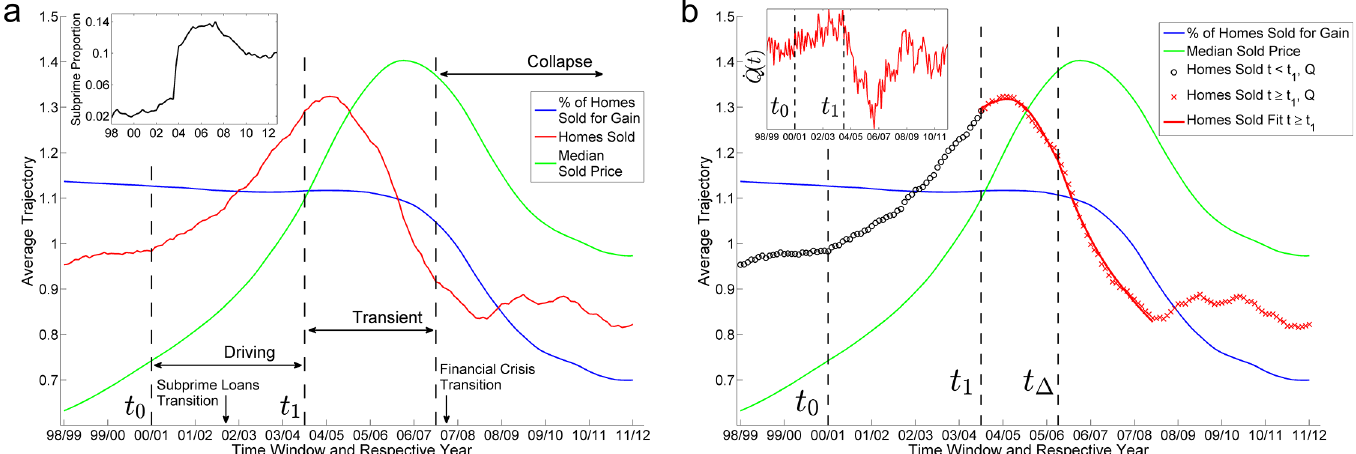
Fig 1. (a) The average normalized trajectories of the three variables are plotted against time . Dashed lines demarcate distinct periods of the trajectory of the US housing market. The start t 0 and end t 1 of the driving phase are marked by kinks in the homes sold trajectory and its gradient respectively while the start of the collapse phase is marked by a collapse in the median sale price and % of homes sold for gain trajectories. (inset) The line plot shows the subprime proportion of mortgages issued in the United States. The sudden jump in the fourth quarter of 2003 is marked on the main figure as the Subprime Loans Transition (October 2003). (b) The average normalized trajectory of the percentage of homes sold for gain variable and the median sold price variable are plotted with the fits of the model to the homes sold trajectory, Q ( t ) . The fitted parameter t Δ , which marks the start of a decline in the fundamental transaction volume, coincides with the start of a collapse in the median sold price variable and the percentage of homes sold for gain variable. _ Q ð t Þ and where a kink is seen at t 1 that (inset) The time derivative of the homes sold trajectory where a kink is seen at t 0 that results in a gradual increase in _ Q ð t Þ results in a steep decline of